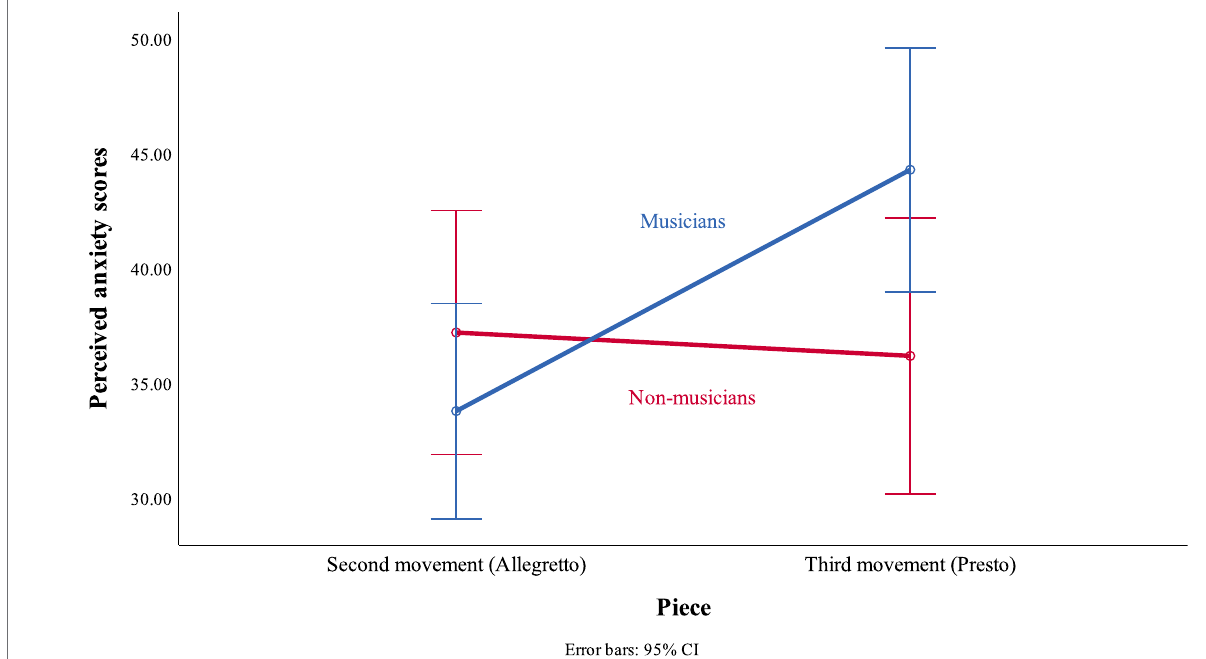
FIGURE 1 | Interaction effect of piece performed and musical background.